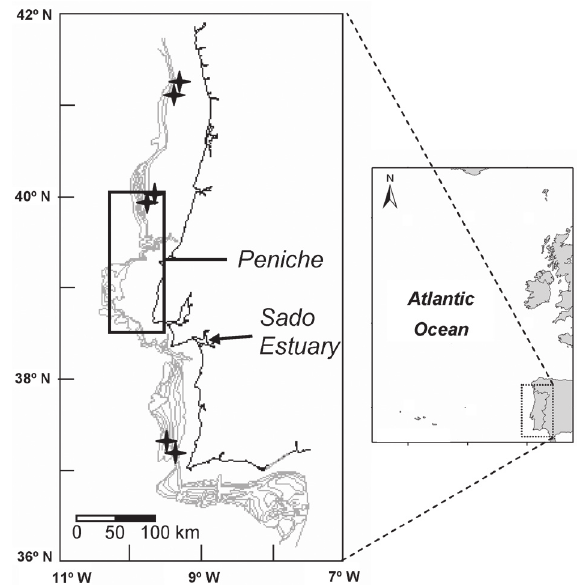
Fig. 1. – sample collection locations: sado estuary, fishing grounds nearby Peniche (square) and position of the research survey hauls with occurrence of specimens of R. undulata ( Á ). The depth range of isobaths varies from 300 to 1000 m (100 m between